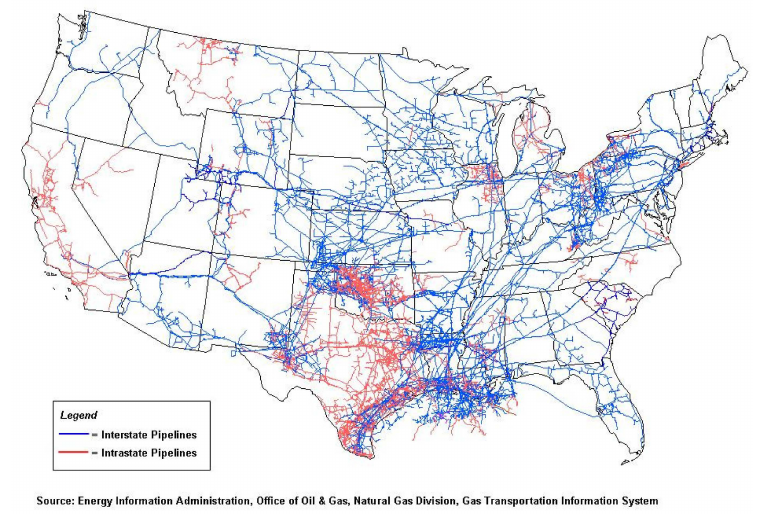
Figure 2. U.S. natural gas pipeline network (Energy Information Administration [22]).